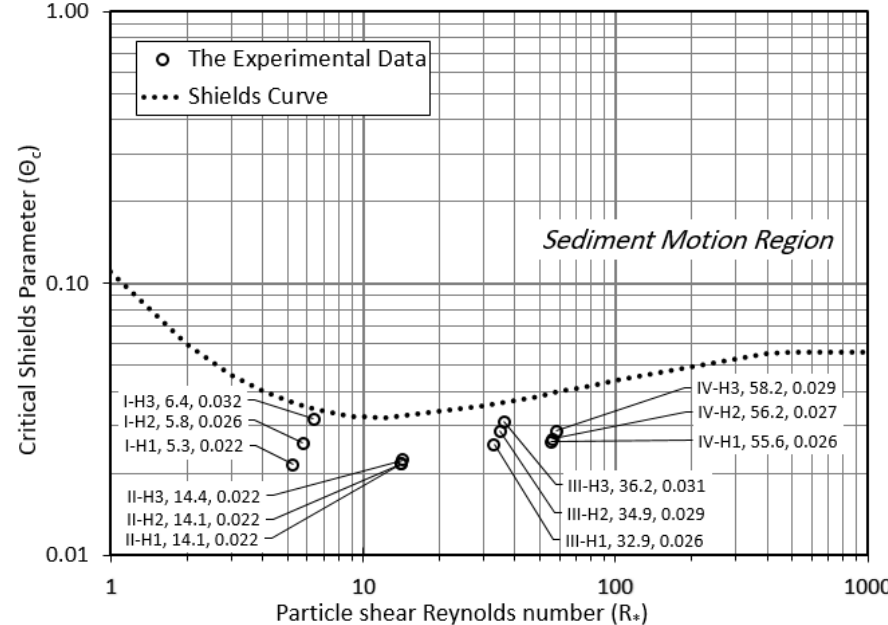
Figure 11. Current experimental results presented in the Shields diagram.